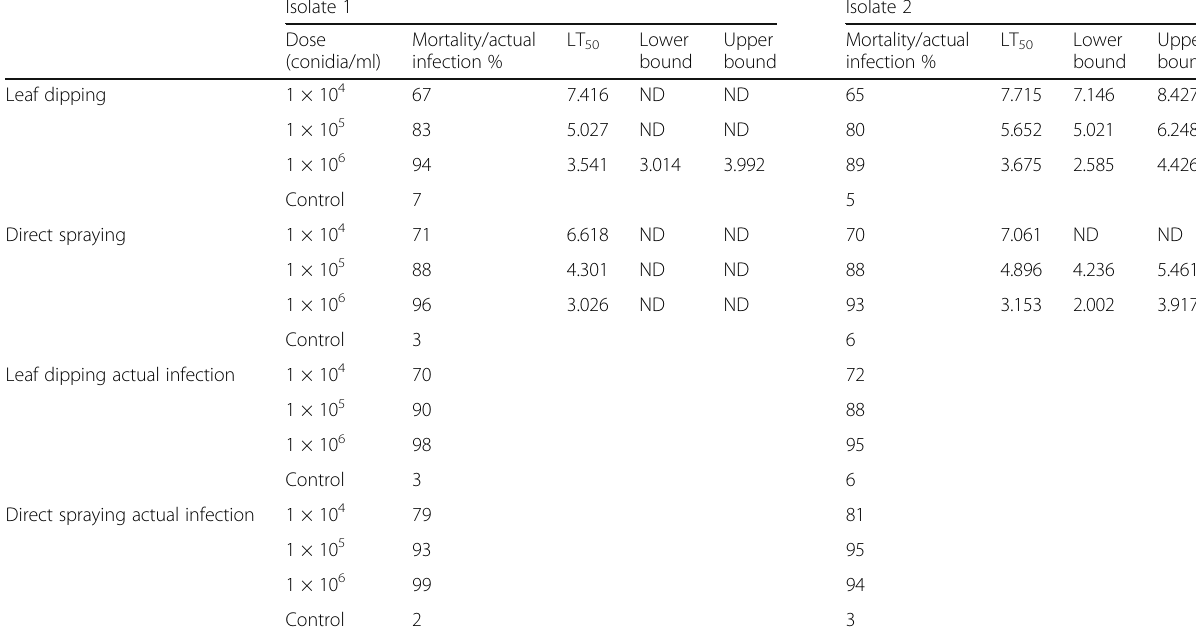
Table 3 Leaf dipping and direct spraying LT 50 values against Orosanga japonica